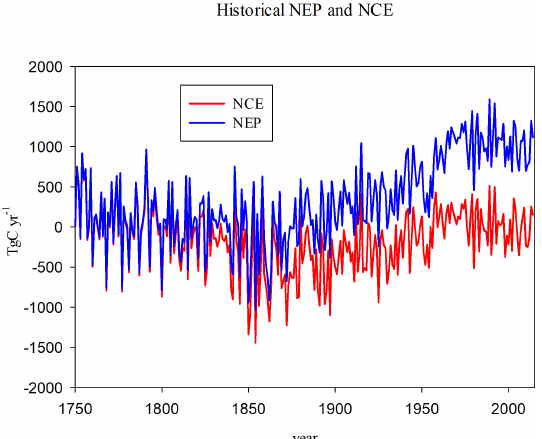
Figure 1. Net carbon exchange (NCE) and net ecosystem pro- ductivity (NEP) for the HISTORICAL run. NCE includes fluxes from agricultural conversion and abandonment and decomposition of agricultural